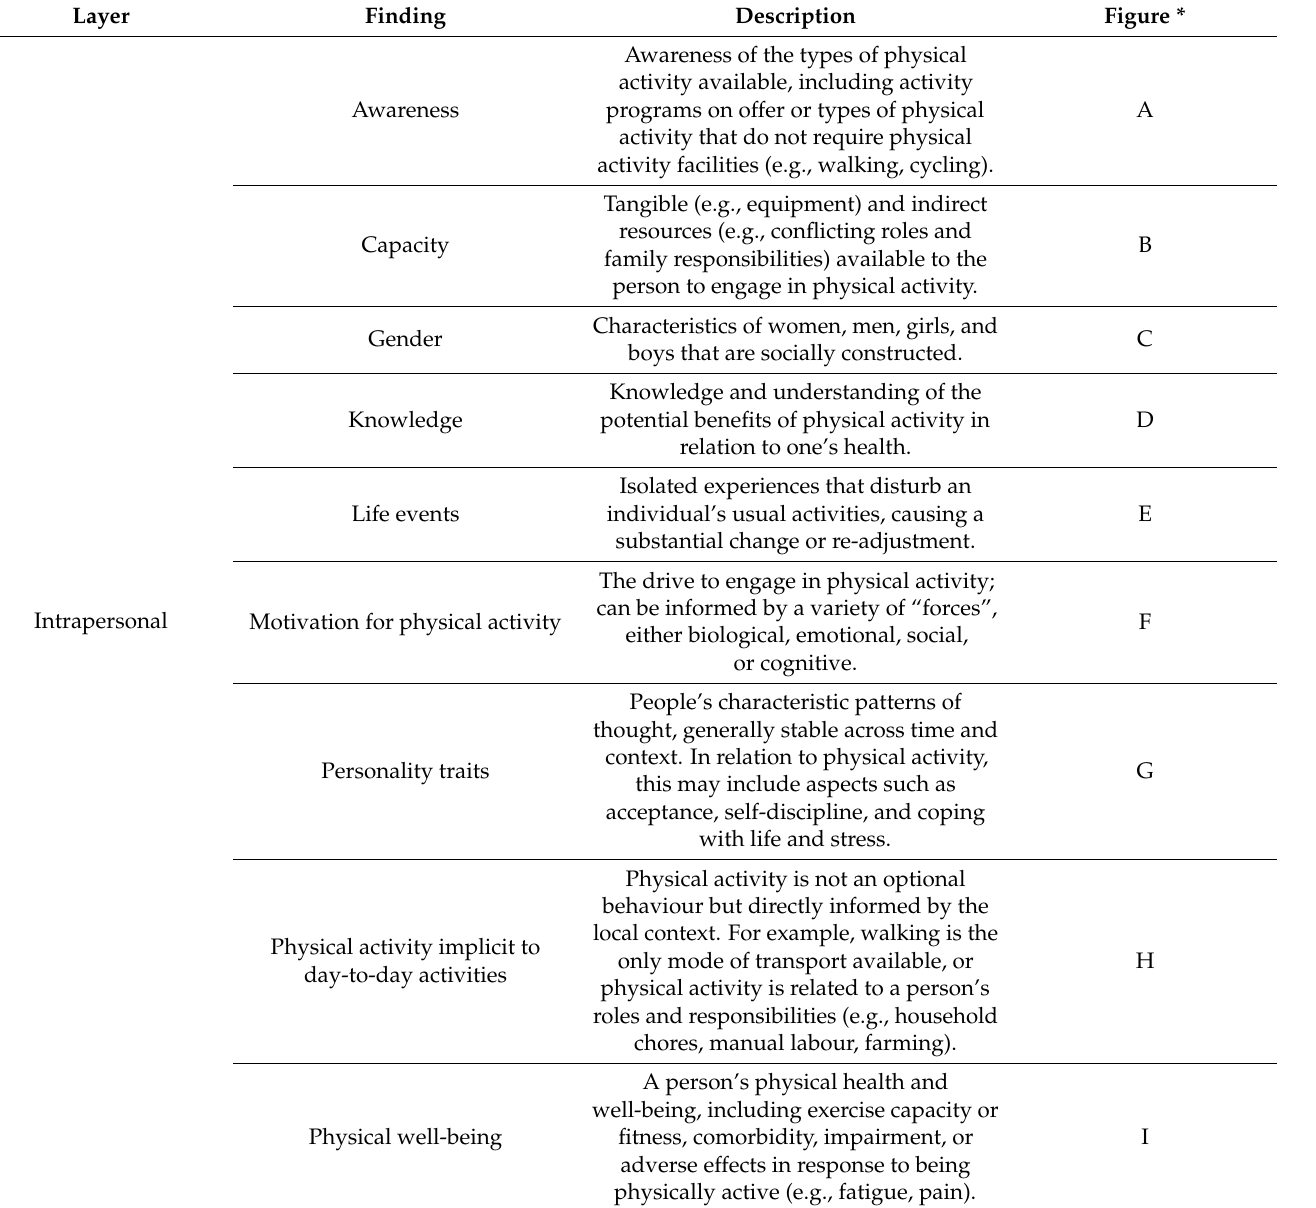
Table 1. Description of the synthesised findings ( n = 26 +